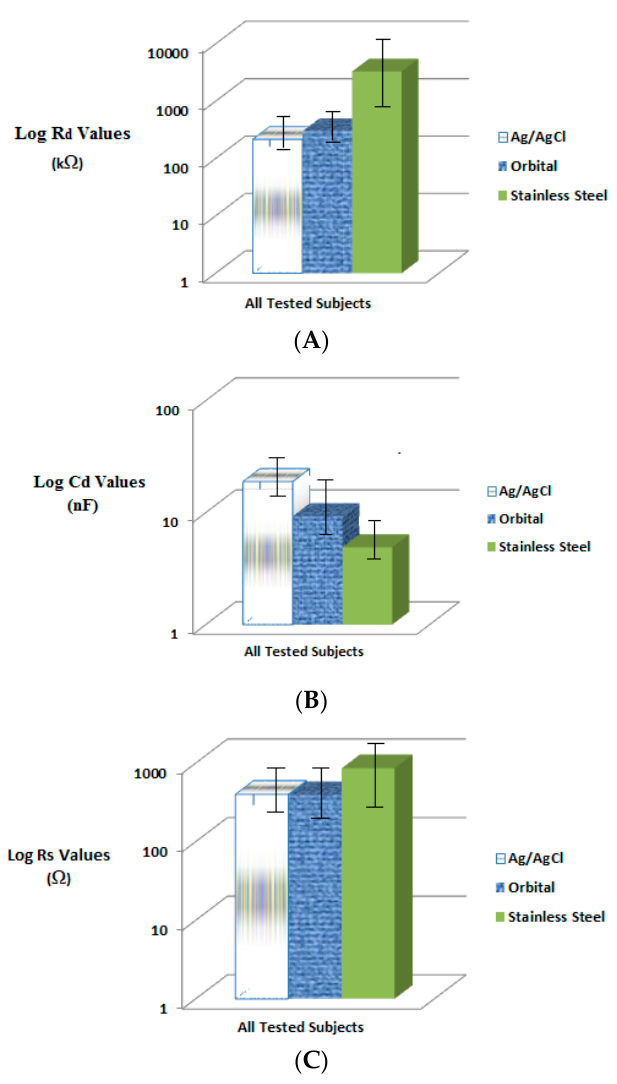
Figure 8. Pregelled Ag/AgCl, Orbital and Stainless Steel electrode’s circuit model components average Log values with standard deviation for all the tested subjects; ( A ) R d ; ( B ) C d and ( C ) R s .